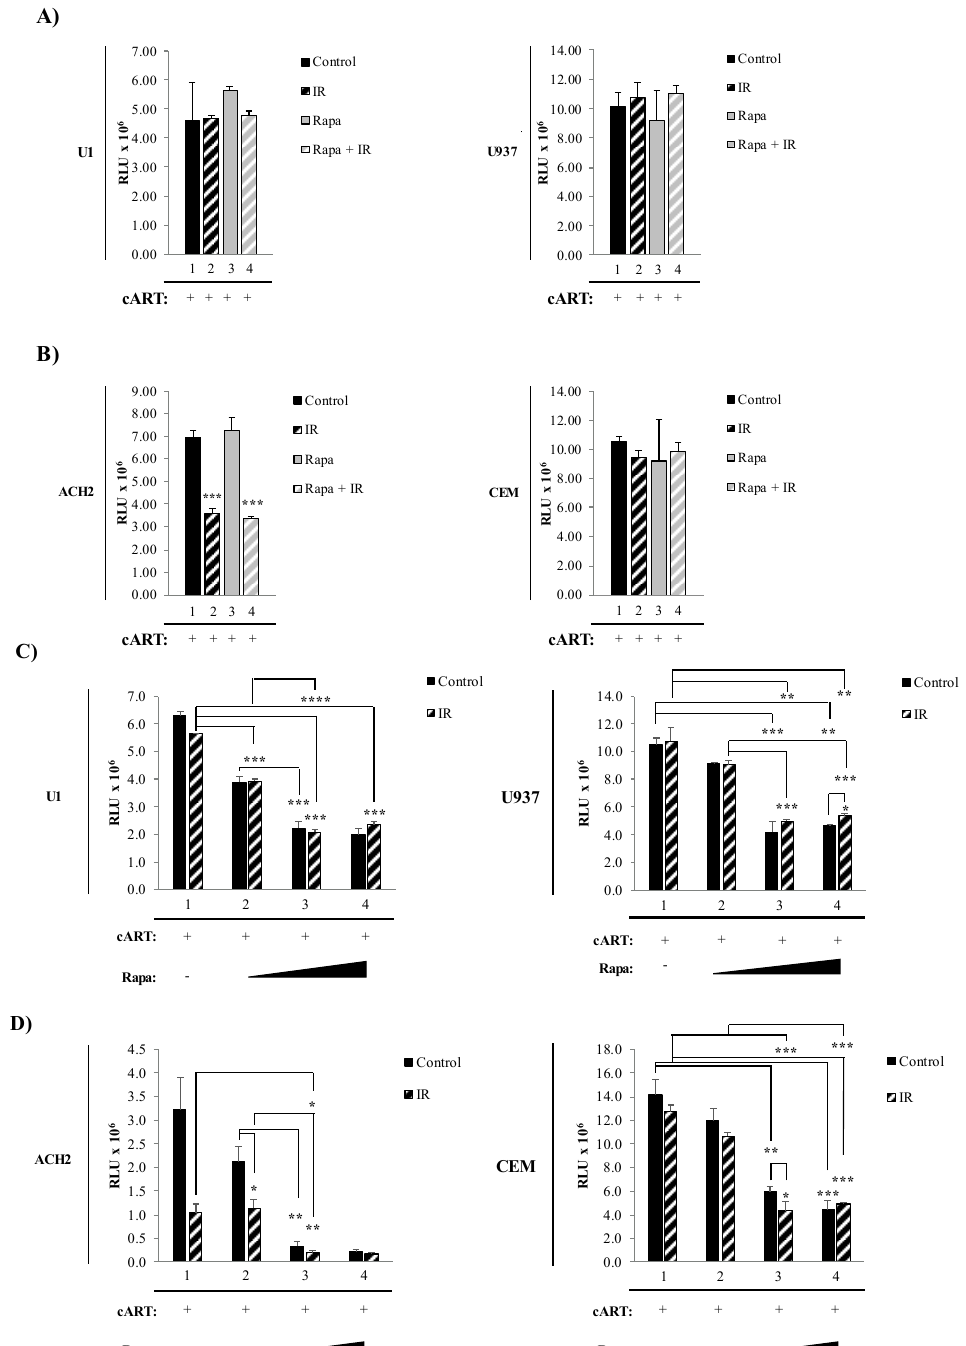
Figure 2. IR and autophagy inducing (AI) drugs a ff ect the cell viability of HIV-1-infected cells. ( A ) Cell viability of HIV-1-infected monocytes cells (U1) was performed 48 h post-treatment with IR (5 Gy), Rapa (50 nM; AI), and IR / Rapa. ( B ) The same treatment was performed on HIV-1-infected T-cells (ACH2). ( C ) The therapeutic window of Rapamycin (Rapa) at 0, 15, 150, and 300 nM was assessed for U1 cells. ( D ) Additionally, the same titration was performed in ACH2 cells. 3.3. The Combination of IR, Serum Starvation, and Mtor Inhibition Induces Cell Death in HIV-1-infected